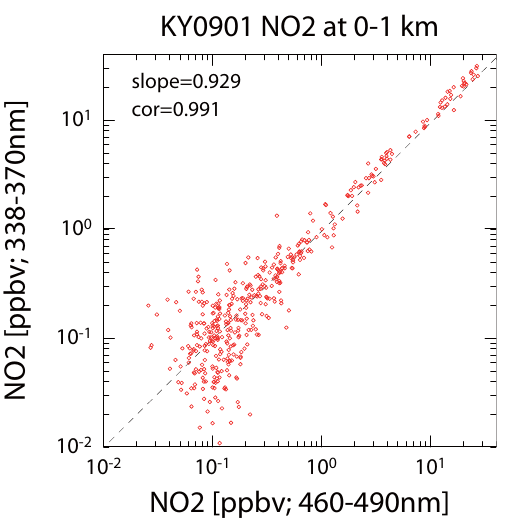
Fig. 8. Scatter plot of NO 2 concentrations for fitting windows of 460–490 and 338–370nm during cruise KY0901.